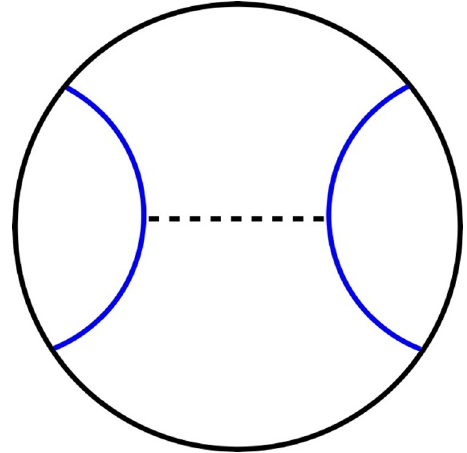
Figure 6 . The tree-level exchange diagram which contributes the O (1 =C ) correction to the con- nected four-point function of two di(cid:11)erent scalar operators V and W